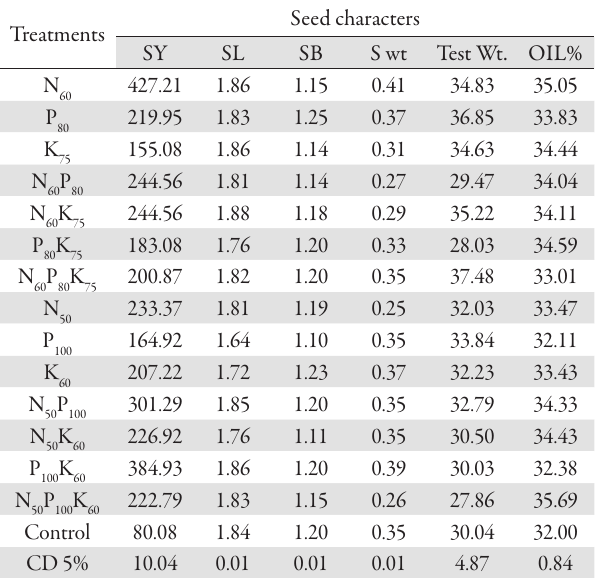
Tab. 4. Effect of N, P and K on seed and oil characters of Jatropha (Pooled) Treatments